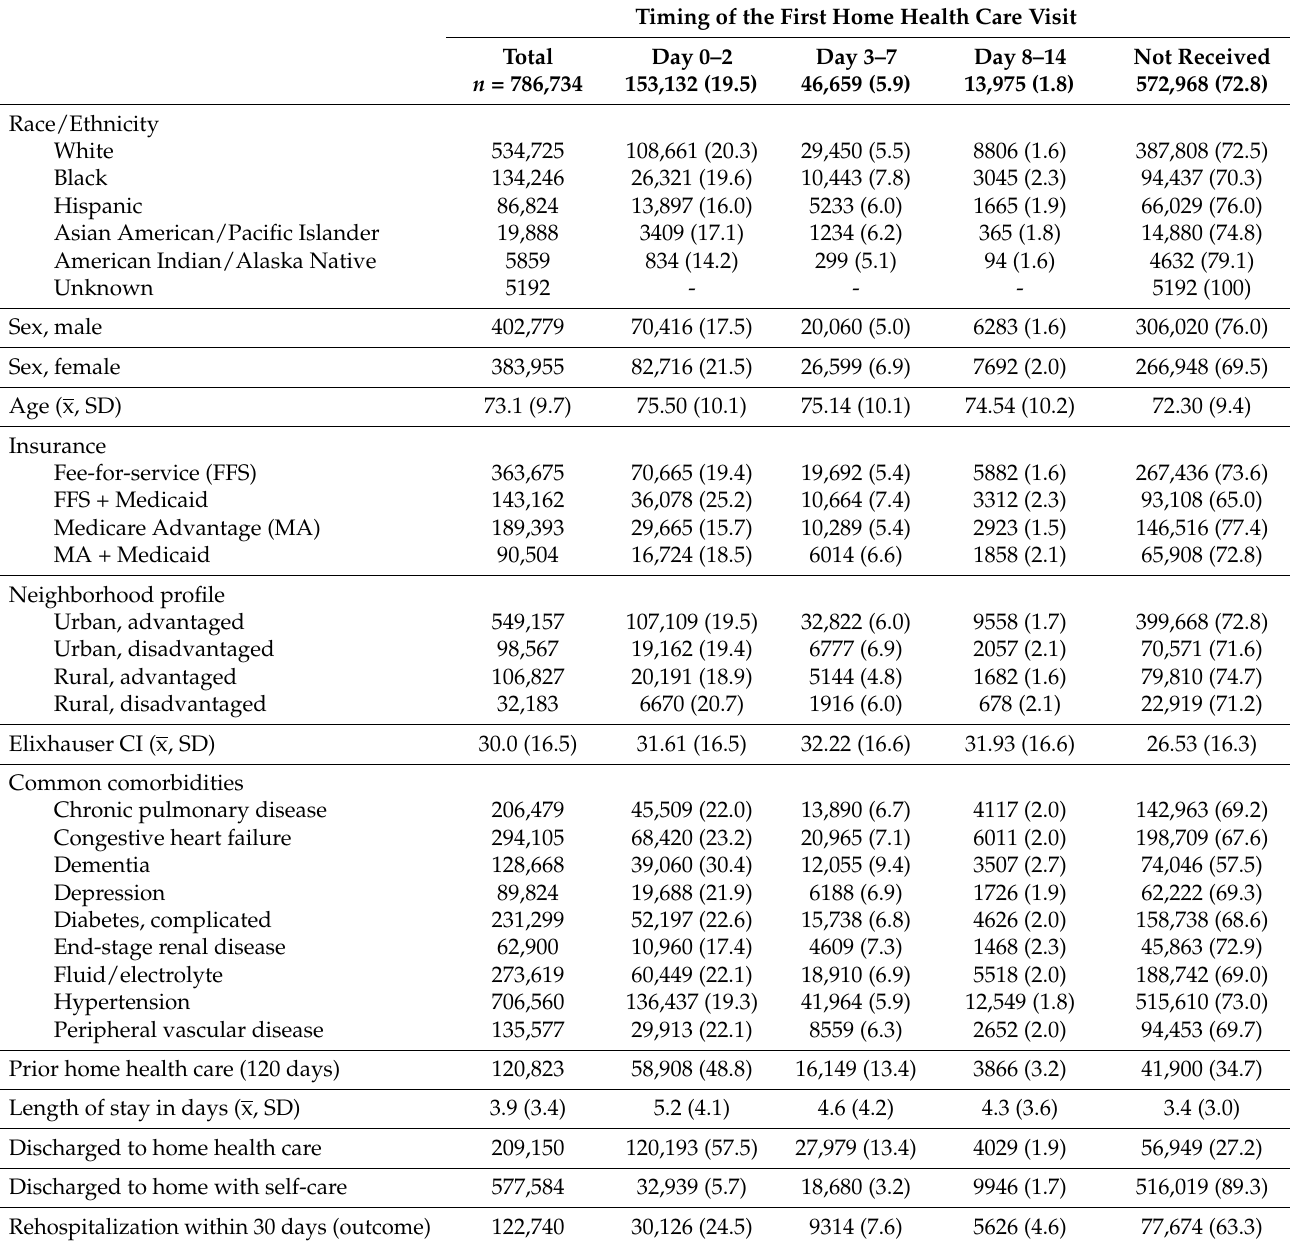
Table 1. Sample characteristics and outcome by timing of the first home health care visit, row percentage